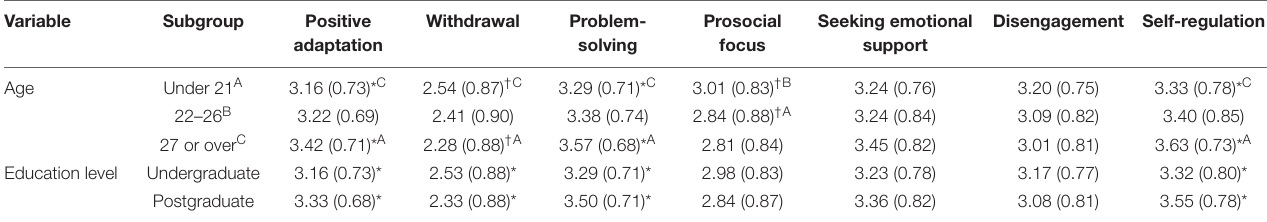
TABLE 4 | Descriptive statistics and ANOVA outcomes for age and education level.